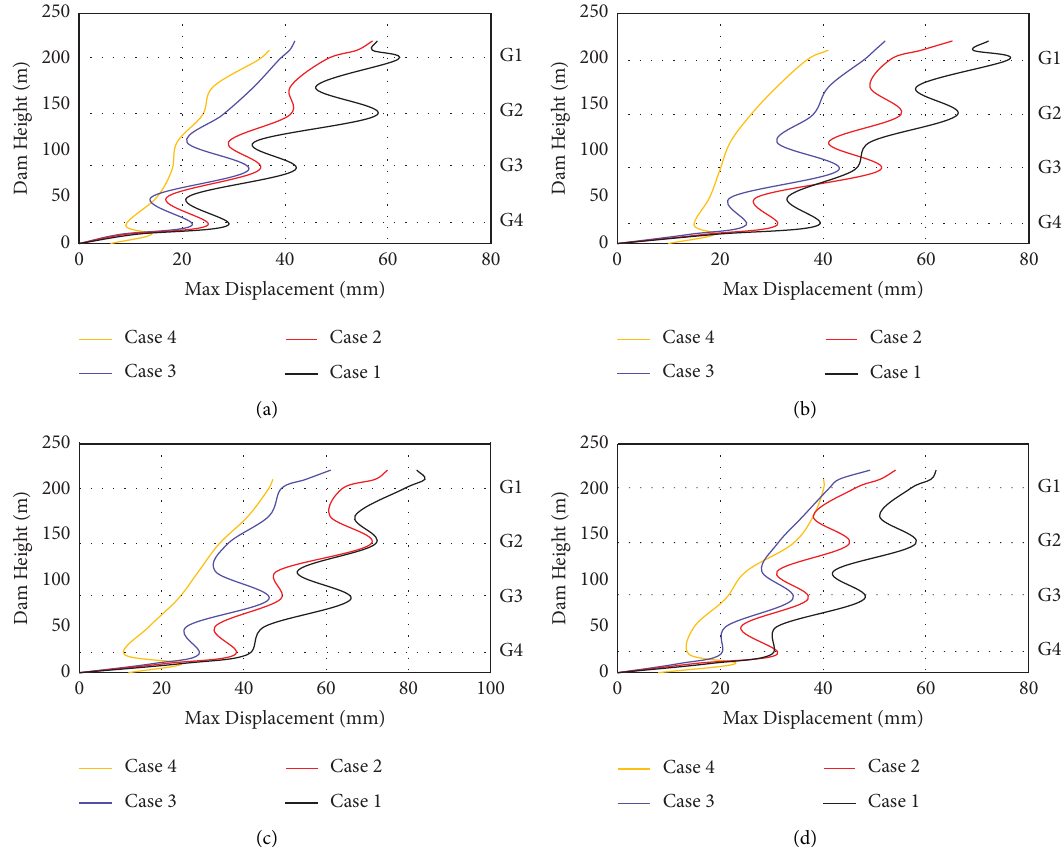
Figure 10: Earthquake displacement results of Ermenek arch dam for EQ9–EQ12 earthquakes: (a) EQ9, (b) EQ10, (c) EQ11, and (d)